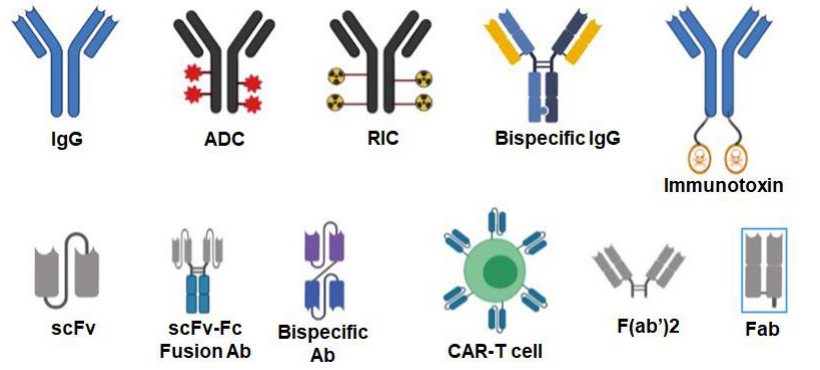
Figure 2. Various formats of antibodies. Antibodies can be used as naked IgG or conjugated to various agents such as drugs (antibody–drug conjugates or ADC), radioisotopes (radioimmunoconjugates or RIC) and toxins (immunotoxins). IgGs can be engineered to target two different antigens (bispecific IgG). Single-chain fragment variables (scFv) can be fused to the IgG Fc domain to generate bivalent scFv–Fc fusion antibodies. scFvs targeting two different antigens can be fused to each other with a linker making them a bispecific antibody. T-cells can be engineered into chimeric antigenic receptor (CAR)-T cells where an scFv is expressed on their surface to target the desired antigen. Smaller antibody formats such as F(ab’)2 and Fab do not contain the Fc region of the IgG. Created with BioRender.com.